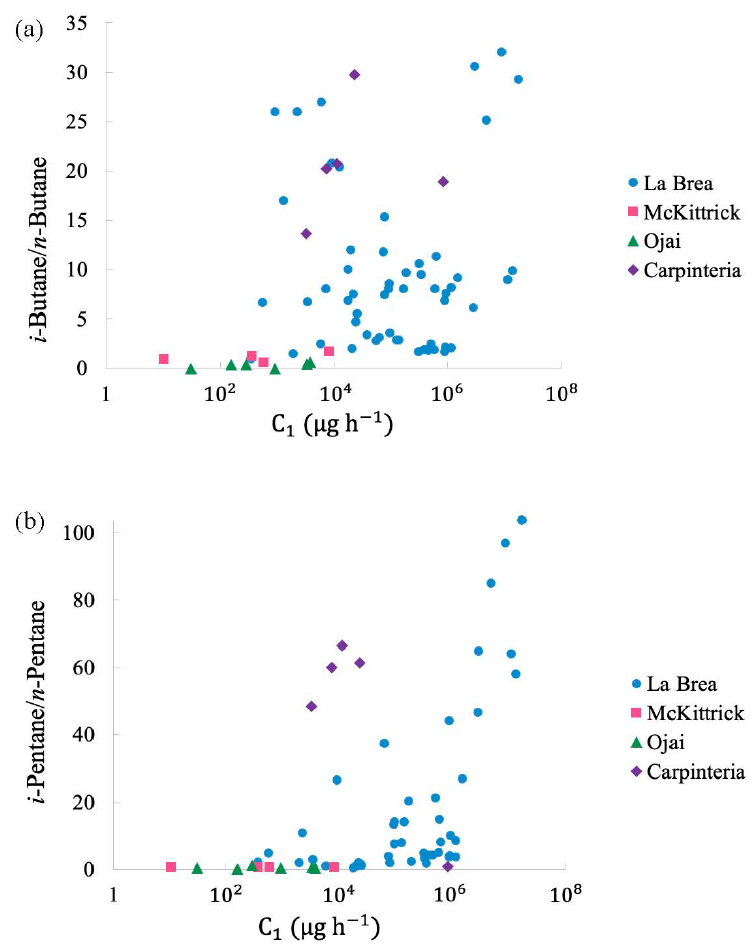
Figure 4. Plots of methane flux vs. ( a ) i -butane / n -butane ratio and ( b ) i -pentane / n -pentane ratio at the three sites and La Brea.